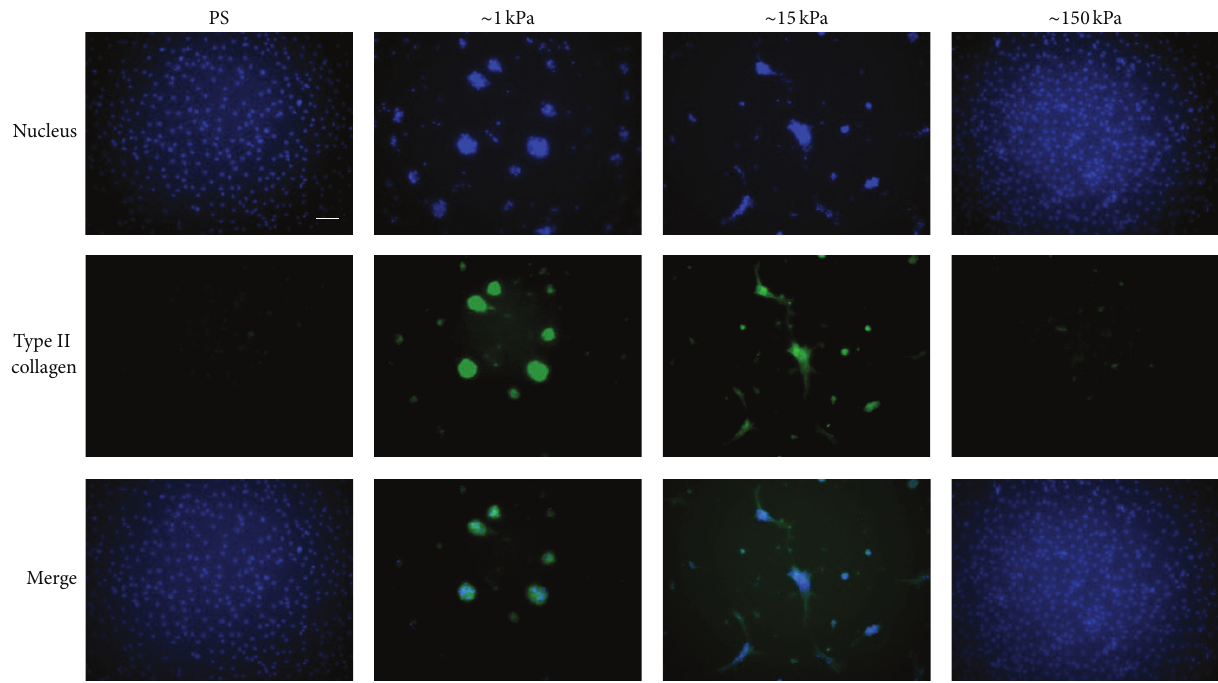
Figure 5: Expression levels of type II collagen in MSCs after 1 week culture on polystyrene dish (PS), S-PAAm gel with E of ∼ 1, ∼ 15, and ∼ 150kPa, respectively. Scale bar, 100 𝜇 m. Type II collagen was detected with immunofluorescent. In the immunofluorescent staining, the cells were stained with an antitype II collagen antibody (green) and Hoechst 33258 (blue). Reproduced with permission from [23]. © 2010, Elsevier,